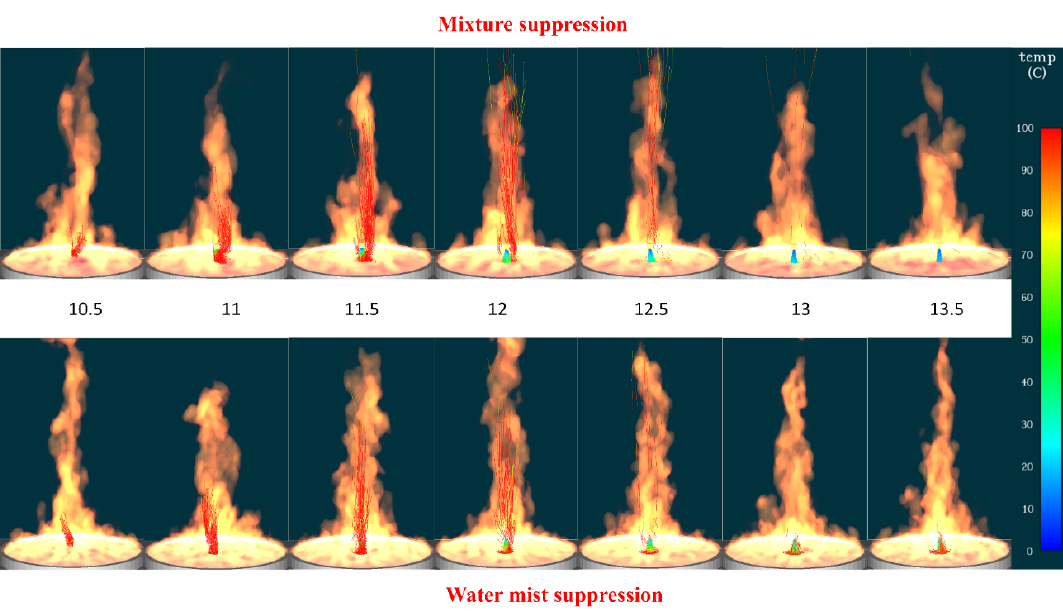
Figure 16. Temperature absorbed by the liquid droplets during both processes. The droplets are traced with 0.5 s. The temperature medium is shown at the right of the figure. The high temperature droplets are shown in red and low temperature droplets in blue. The maximum temperature sustained by the water particles is also shown on the left of Figure 16. As we